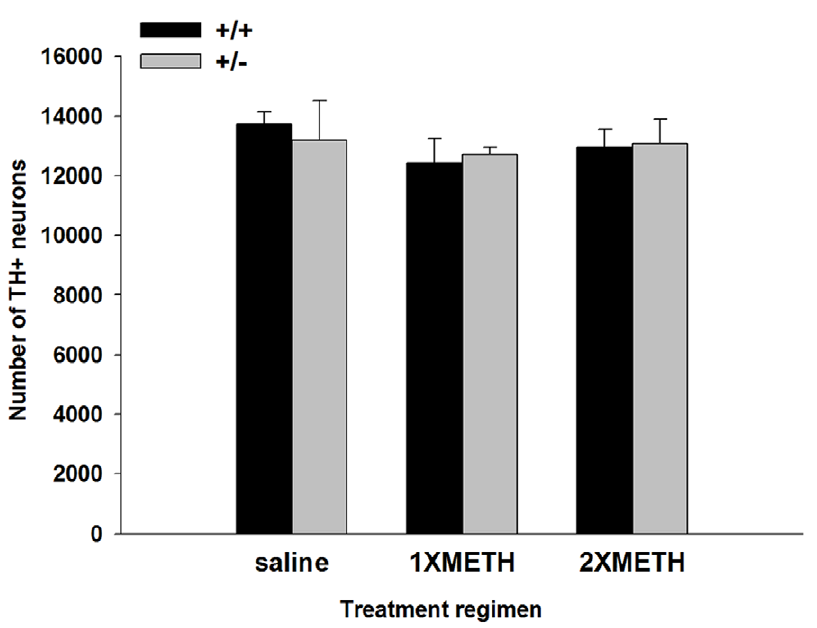
Figure 4. Stereological counts of SNpc TH-positive DAergic neuron numbers. DAergic neuron numbers in Nurr1 + / + and + / 2 mice treated with saline, 1XMETH and 2XMETH were estimated using unbiased stereologic principles. METH binge treatment does not lead to loss of dopaminergic neurons in SNpc (p=0.556, F (2,17) =0.617, Two-way ANOVA). Furthermore, there is no difference between wt and heterozygous mice (p=0.957, F (1,17) =0.003, Two-way ANOVA).